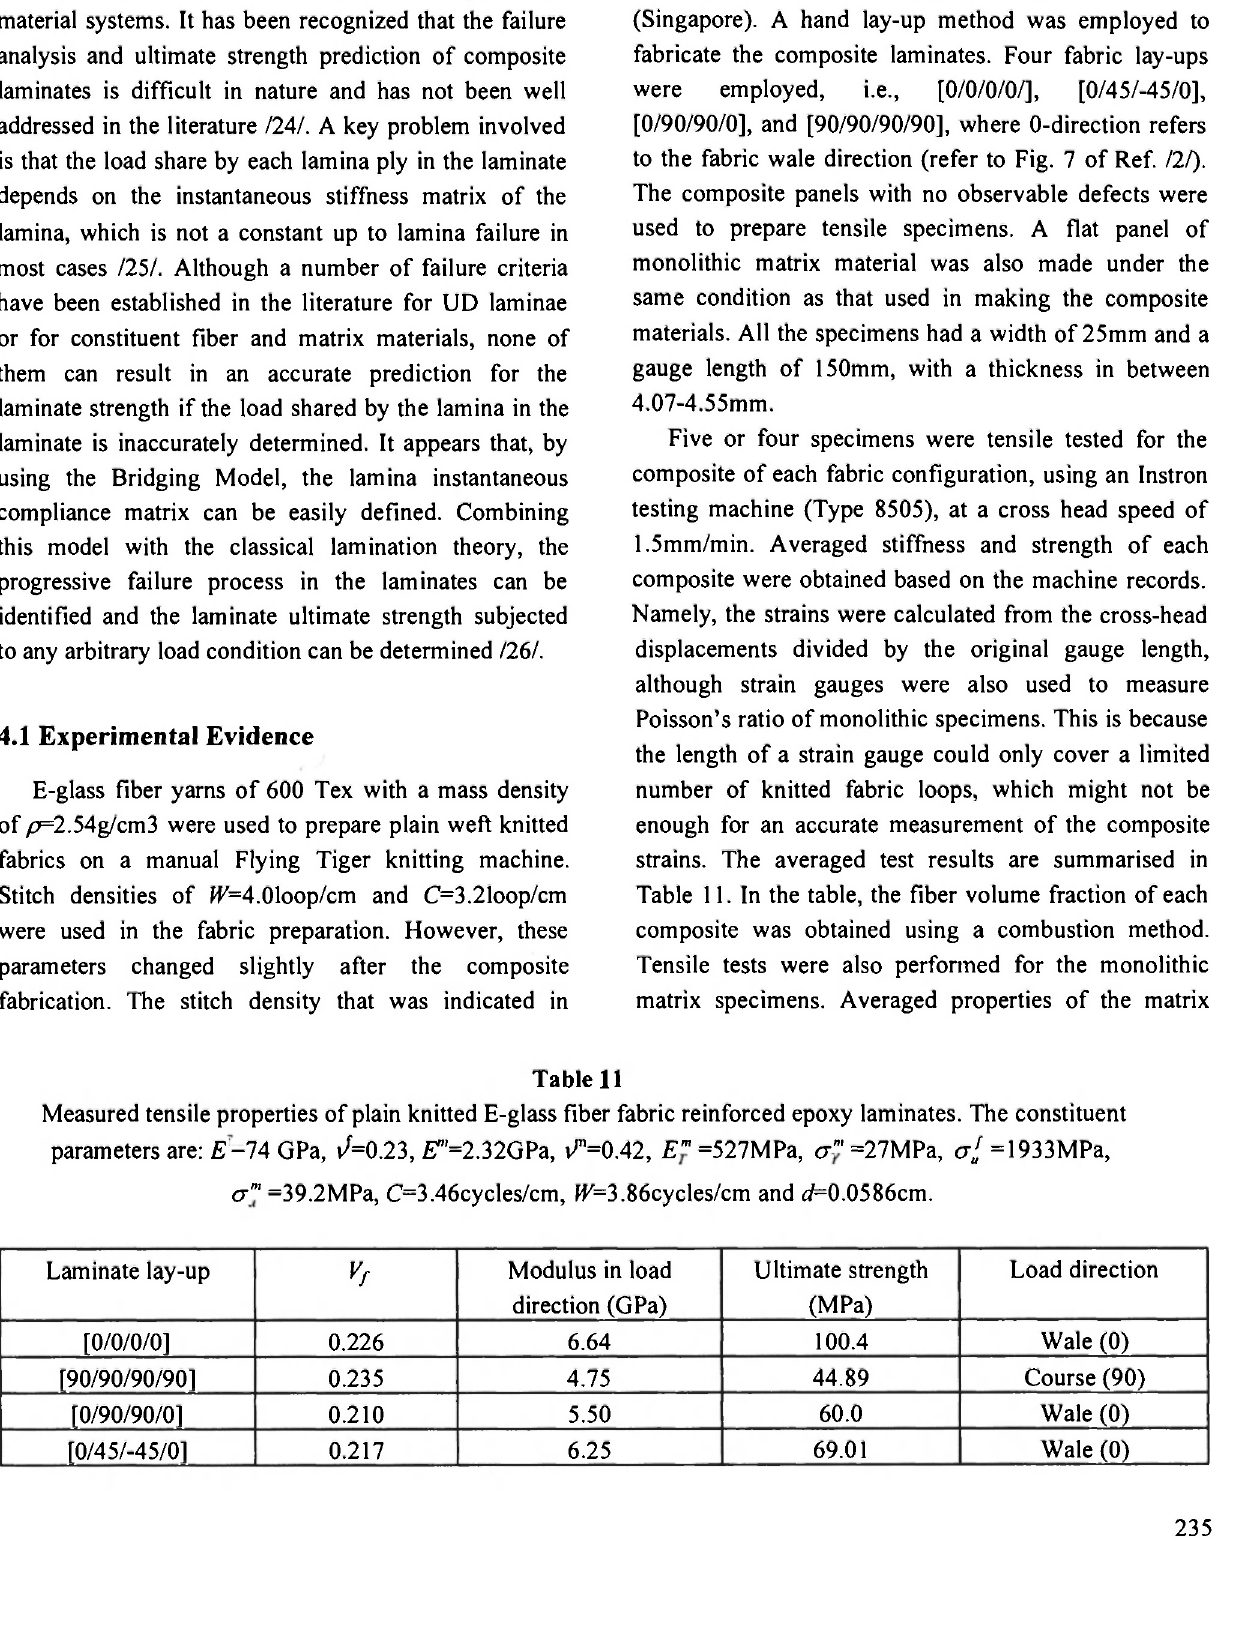
Table 11 was an averaged measurement from the composite panels. The matrix used was a mixture of an epoxy resin R-50 and hardener H-64 (100 to 48 in ratio